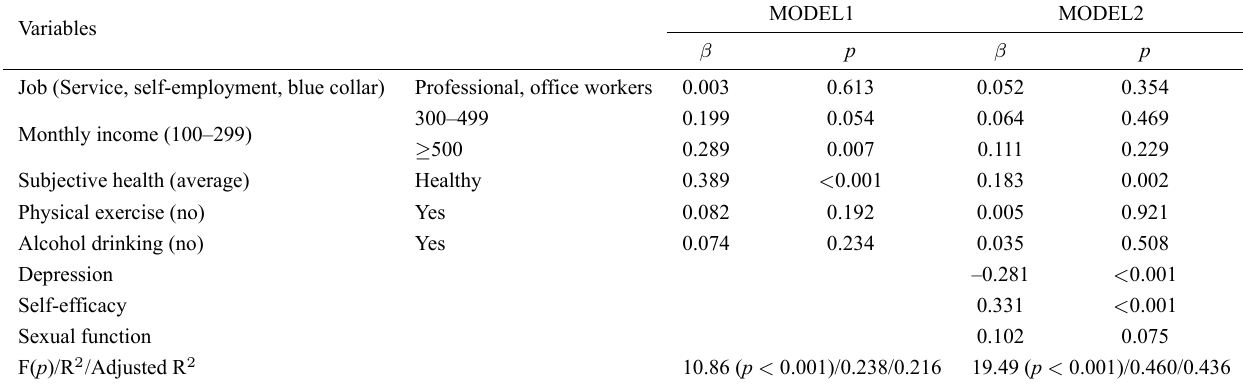
Table 4. Influencing factors of quality of life (N =